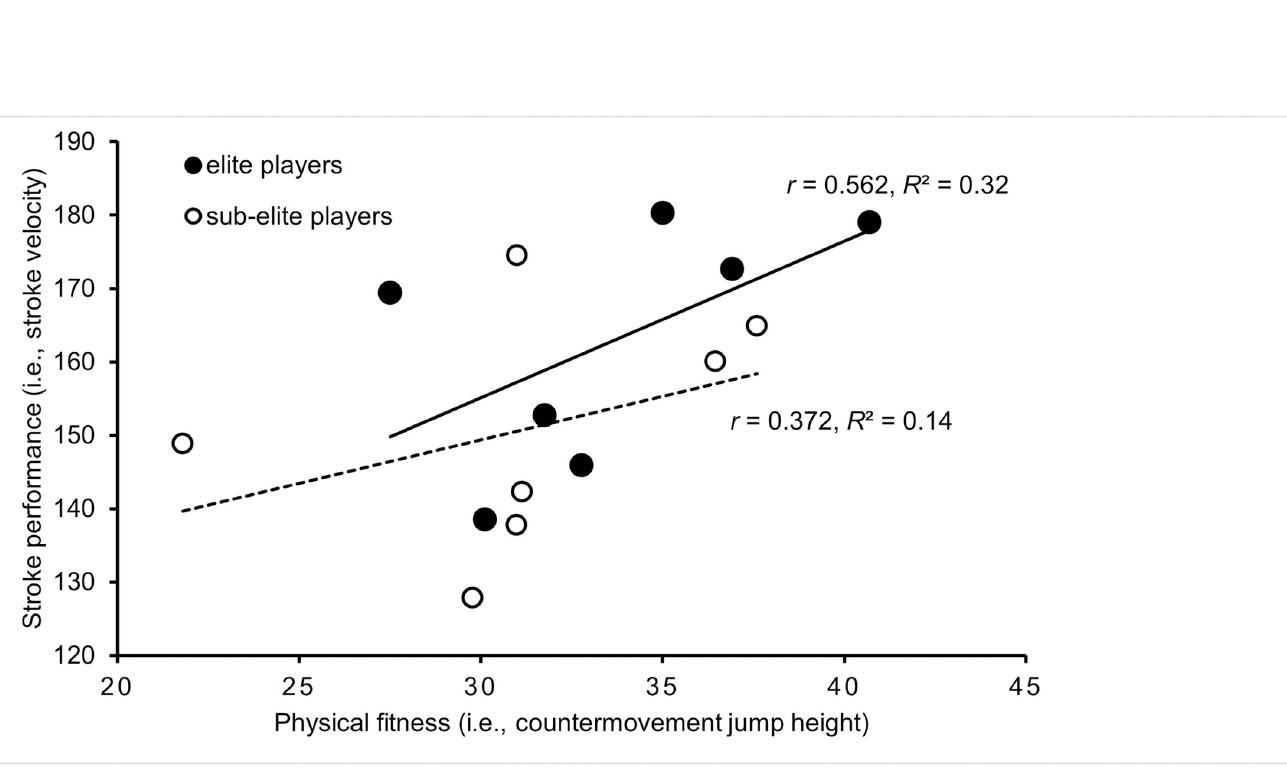
Fig 7. Correlations between physical fitness (i.e., lower extremity muscle power) and stroke performance (i.e., stroke velocity) by competition level. Filled circles and the solid regression line indicate elite tennis players and unfilled circles and the dotted regression line indicate sub-elite tennis players. r = Pearson’s correlation coefficients, R 2 = coefficient of